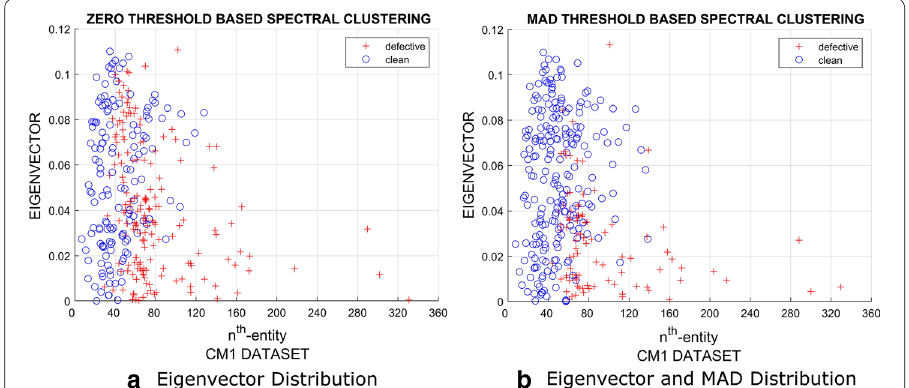
Fig. 2 Predicted clusters result. a , b illustrate an example of the cluster memberships of CM1 dataset, which are constructed using the zero threshold based spectral clustering and MAD threshold based spectral clustering, respectively. Related to Table 4, the use of MAD as partitioning threshold can increase the number of predicted cluster